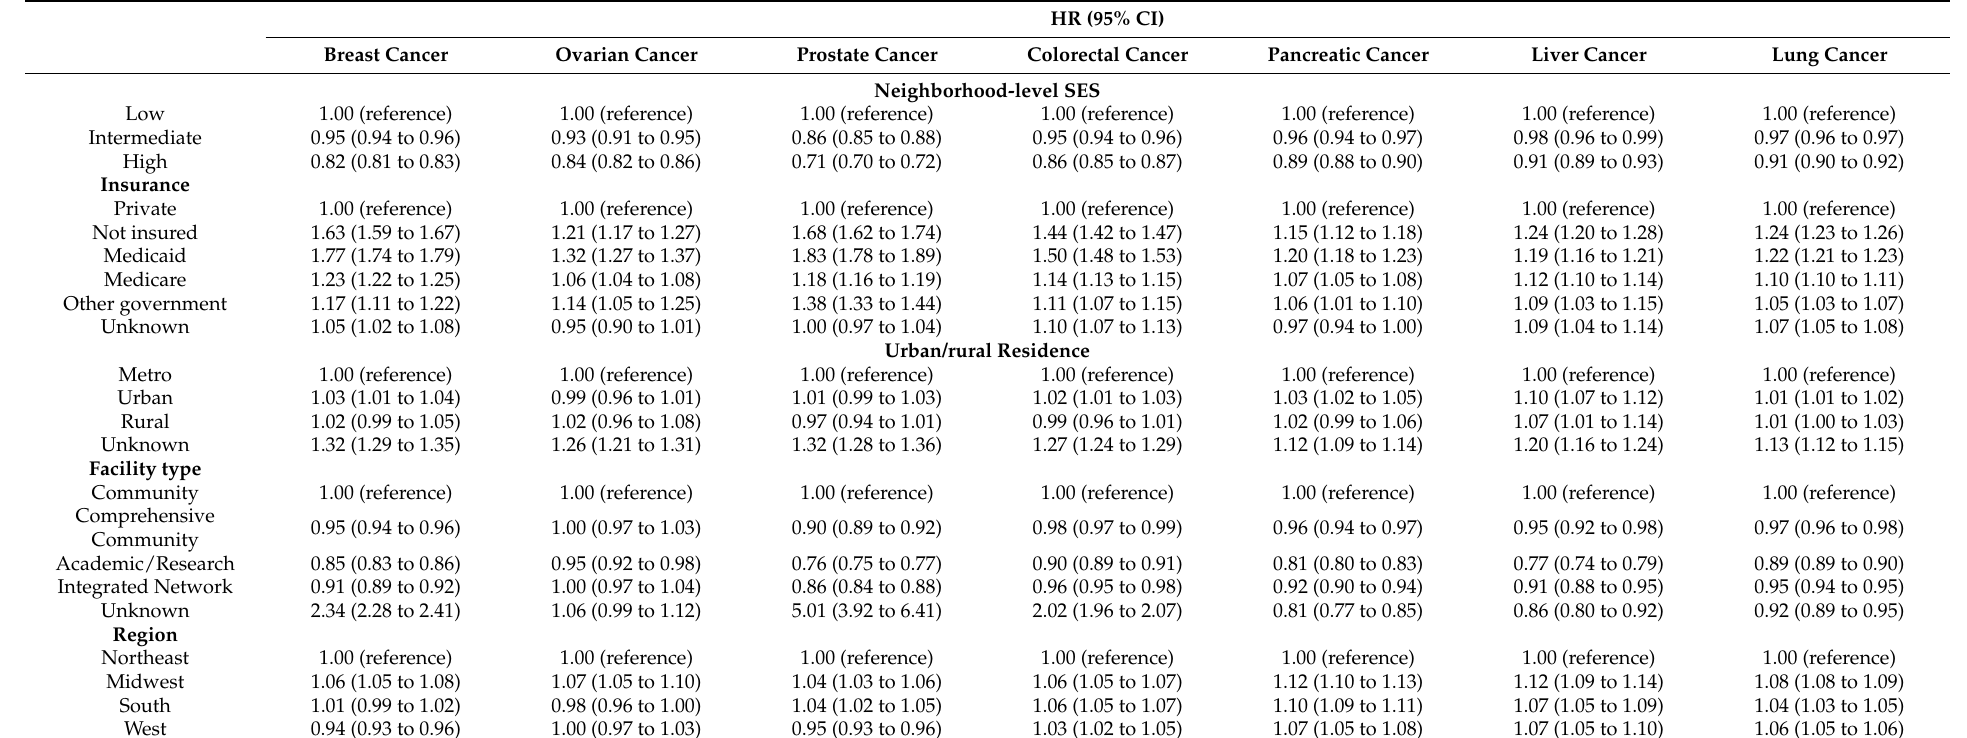
Table 3. Association of factors related to access to care with total